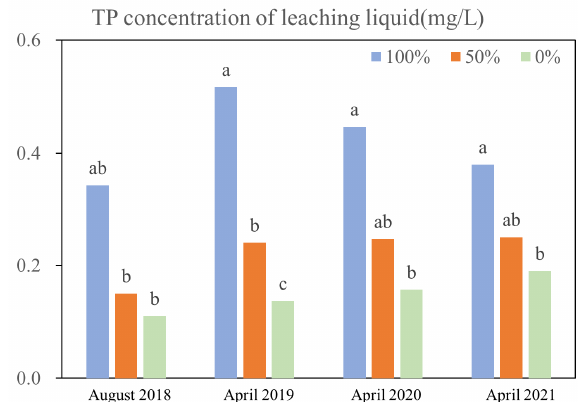
Figure 9. TP concentration of leachate under different residue removal rates. Different lowercase letters above the bars indicate significant differences among treatments ( p < 0.05 ).